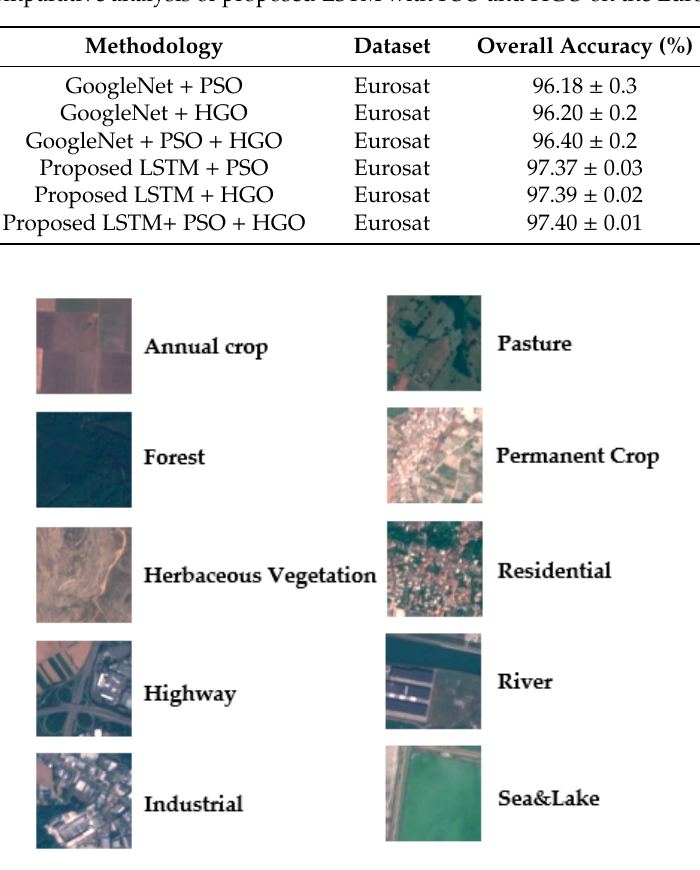
Figure 15. Sample image patches of the Eurosat dataset.